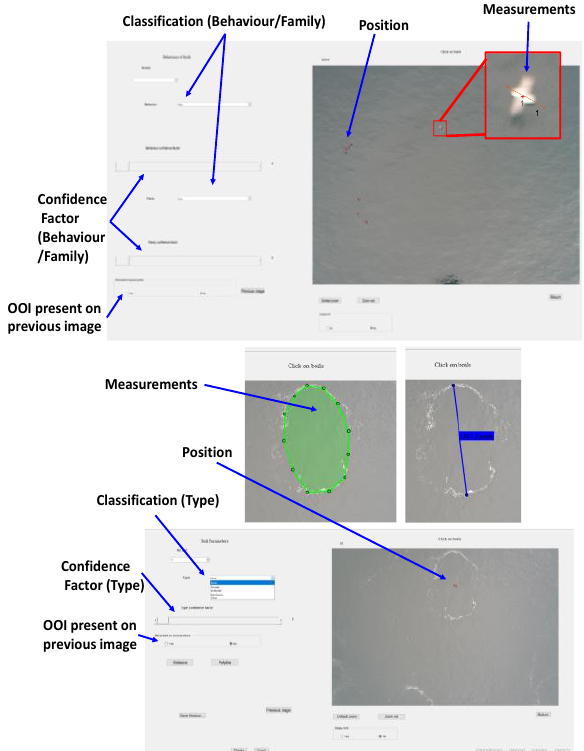
Fig. 4. Examples of the GUI display presented to users when processing imagery, highlighting the ability to record both faunal (top image) and turbulence (bottom image)